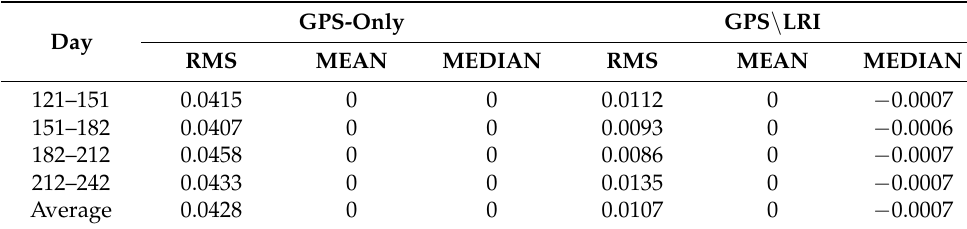
Table 11. Statistics of KBR check (unit: